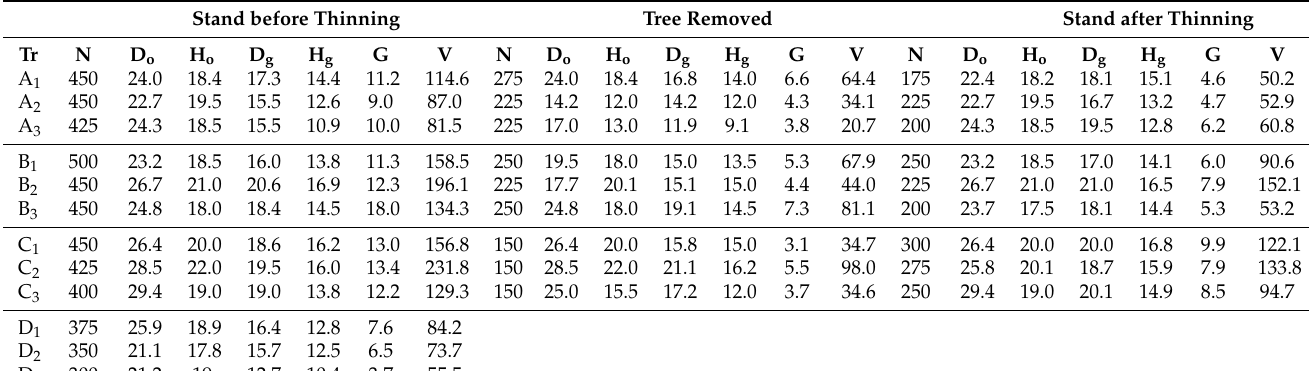
Table 1. Evolution of the main stand variables before and after thinning in the laurel agroforestry system, Sumaco Protected